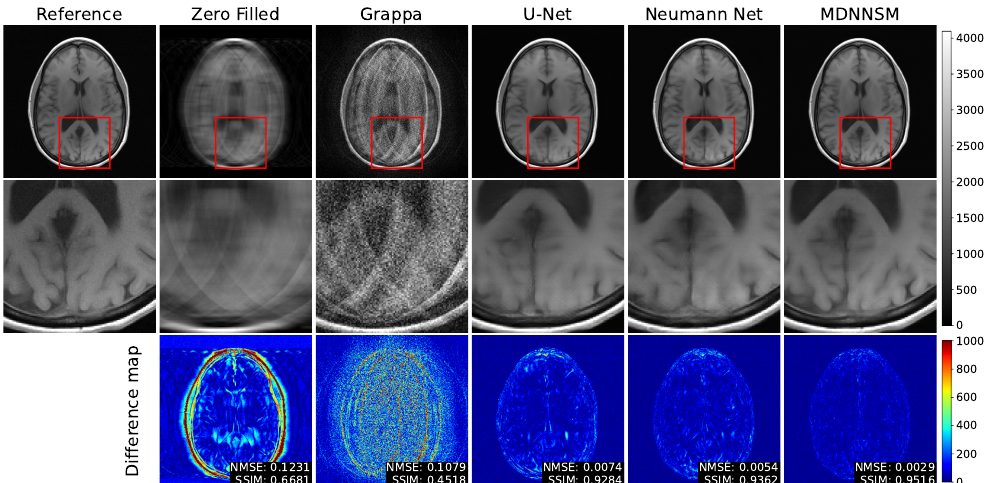
Figure 7. The top row shows fully sampled and reconstructed T1-weighted images using the zero- filled, Grappa, U-net, Neumann network, and MDNNSM methods, with an acceleration factor of 8 and an ACS rate 4%. The middle row shows detailed images zooming the red box area of the top row. The bottom row shows the difference between the reference and reconstruction images. The MDNNSM showed the lowest NMSE and the highest